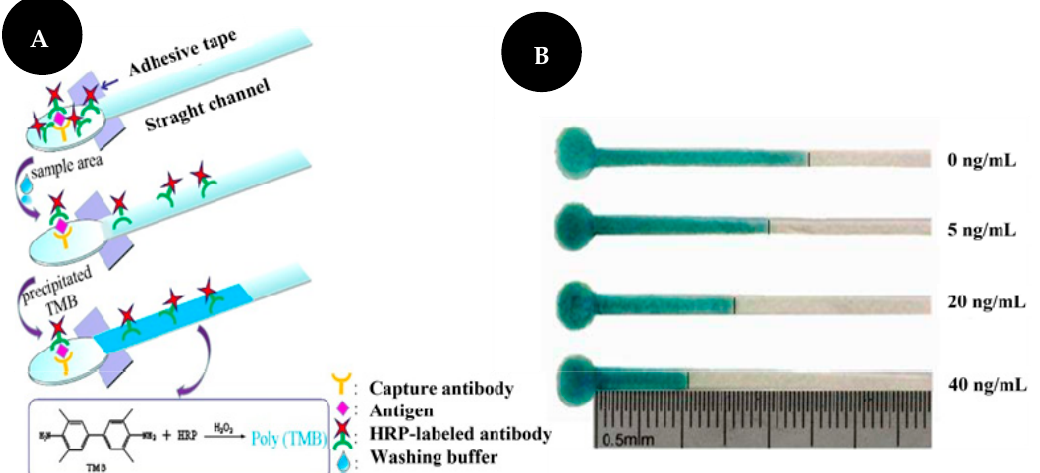
Figure 4. Scheme of distance-based detection of CEA ( A ). Results of CEA detection ( B ). Reproduced and adapted with permission from [15].